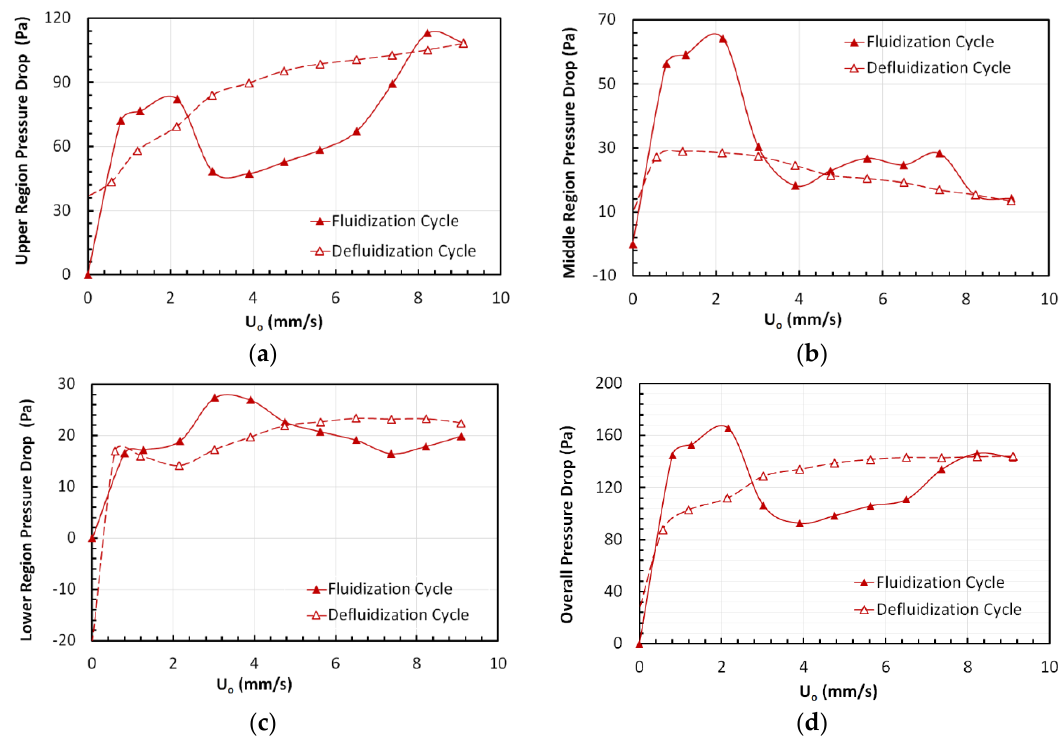
Figure 9. E ff ect of velocity on the pressure drop in di ff erent regions of the fluidized bed during the fluidization and defluidization cycles ( a ) Upper ( b ) Middle ( c ) Lower ( d ) Overall.